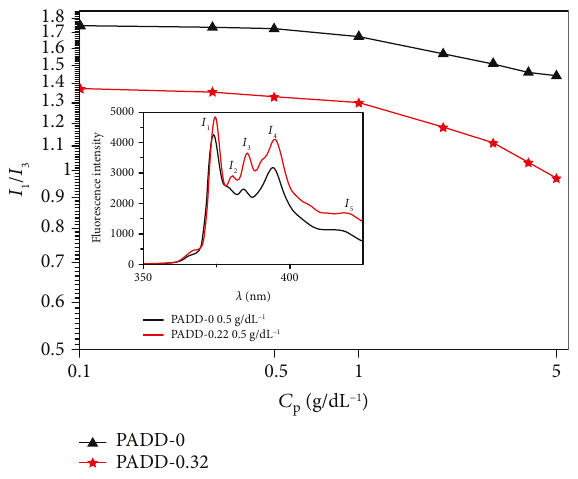
Figure 5: Fluorescence spectrum of PADD (probe,